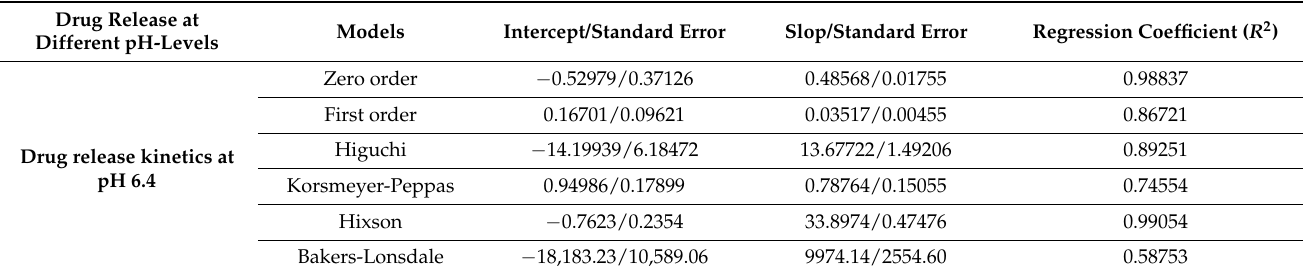
Table 1. The drug release kinetics summarizes against different models to determine the best-fitted model at different pH levels (6.4, 7.4, and